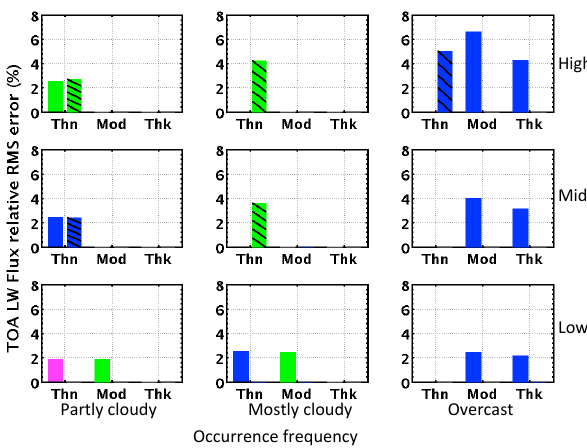
Figure 10. Same as Fig. 9, but over land.